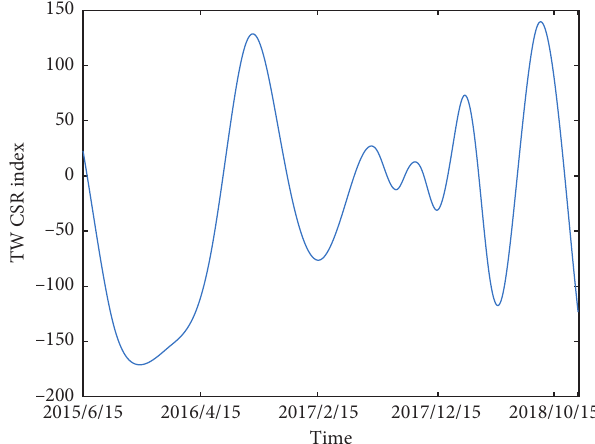
Figure 17: EMD analysis of the Taiwan CSR index used to get IMF5.